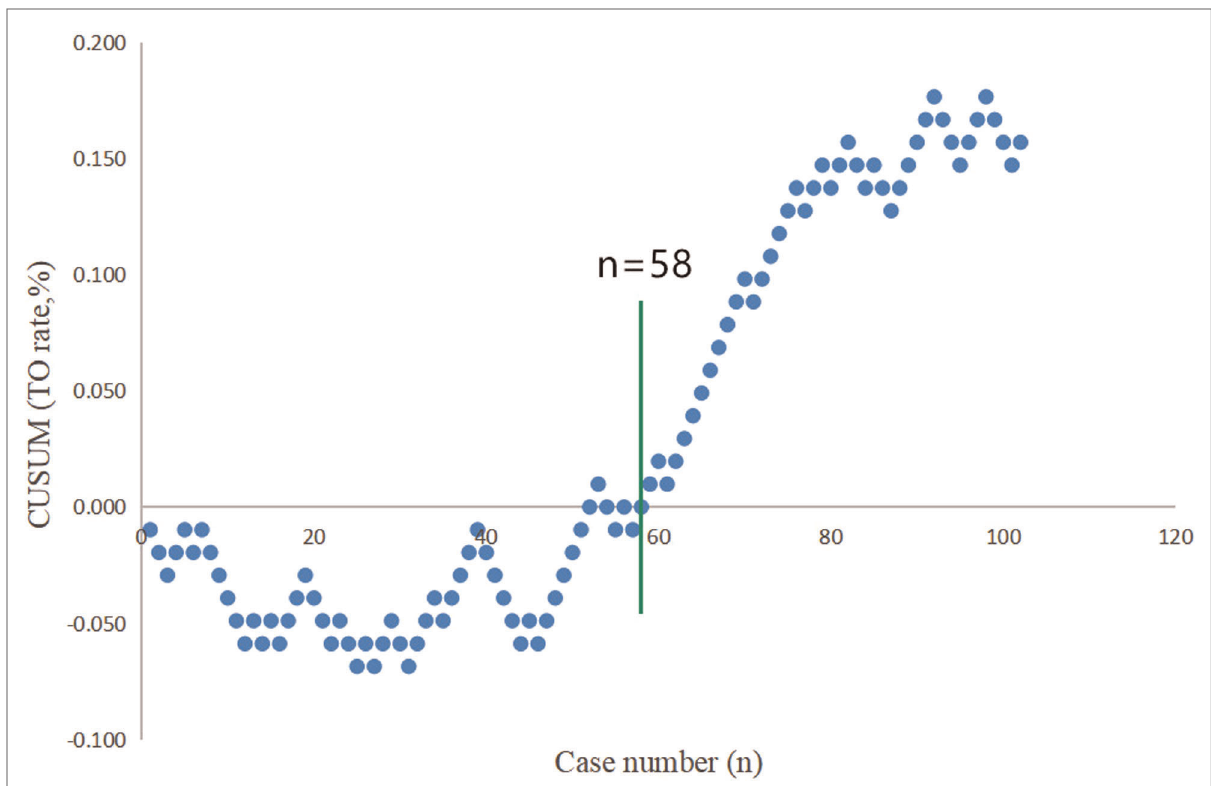
FIGURE 2 “ Textbook outcome (TO) ” for robotic SADI-S was de fi ned by all of the following 5 parameters: operative time ≤ 210 min, the length of postoperative stay ≤ 6 days, postoperative morbid event <Clavien grade II, no conversion to laparotomy, and no rehospitalization or death after totally robotic SADI-S. TO was recorded when all of the aforementioned parameters were observed. The rate of TO for robotic SADI-S is positive and is steadily increasing after the number of surgical cases accumulated to the 58th case.